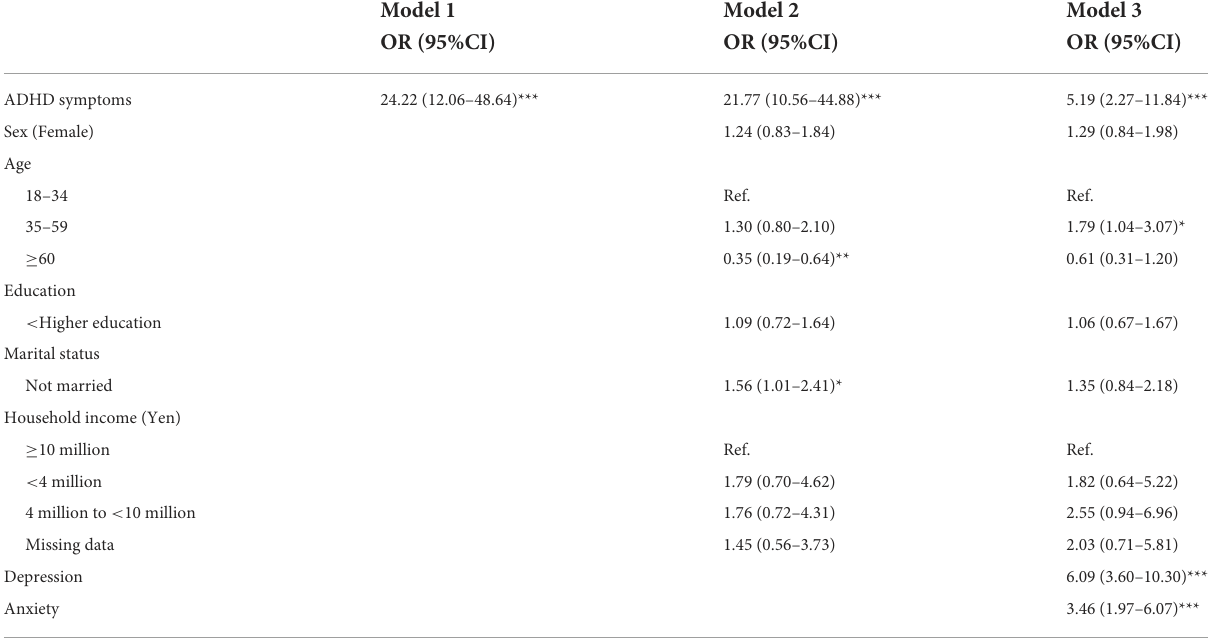
TABLE 2 Association between ADHD symptoms and perceived stress in Japan during the COVID-19 pandemic ( N =